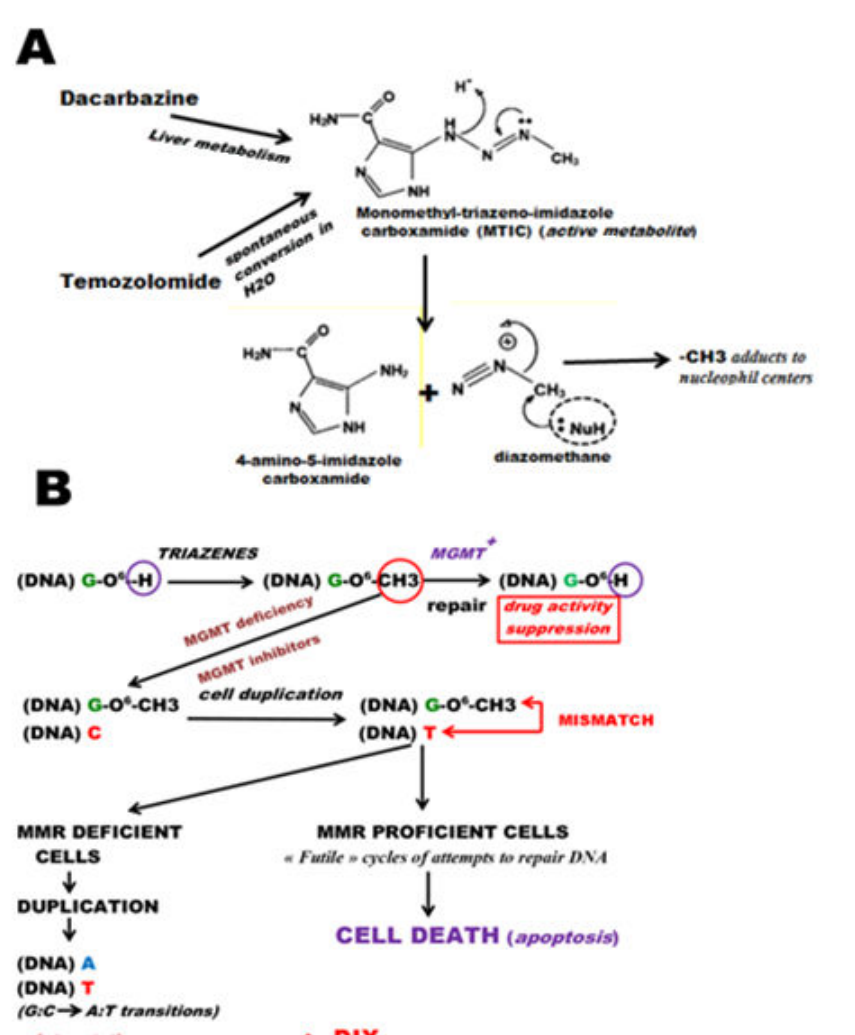
Figure 3. Biochemical basis of the DIX effect due to exposure to triazene compounds. ( A ) Dacarbazine (DTIC) is a prodrug that requires liver metabolism to be converted into the active MTIC metabolite. On the other hand, temozolomide, an often-used triazene compound, does not require metabolic activation since it is spontaneously converted into MTIC in aqueous solution. Thereafter, MTIC generates the final active molecule, diazomethane, a mono-methylating agent able to produce methyl adducts to nucleophil centers in the DNA. ( B ) The most significant methyl adducts to DNA produced by triazenes relative to their pharmacodynamic properties include O 6 MeG, N7-methylguanine, and N3-methyladenine [209]. At therapeutic dose levels, particularly involved in the cytotoxic and DIX effects of triazenes is O 6 MeG. If this adduct is repaired by MGMT, triazenes are essentially inactive [19,210,211]. If the activity of MGMT is spontaneously low or downregulated by drugs (e.g., lomeguatrib [212]) O 6 MeG mispairs with thymine. If MMR is functionally active, the complex tries to repair the mismatch by replacing the new DNA strand without success. It is presumed that several “futile cycles” of DNA repair lead to cell death through apoptosis. However, a few resistant clones that are inefficient for MMR or that do not trigger apoptosis continue to proliferate and display point mutations (GC->AT), giving rise to the appearance of strong tumor neoantigens (i.e., the DIX effect). Based on these considerations, it is obvious that MGMT downregulation appears to be mandatory for DIX achievement with triazenes. It must be underlined that the majority of preclinical studies on DIX have been conducted on mouse leukemia/lymphoma cells that express low levels of MGMT [213,214]. Actually, there are a number of drugs able to